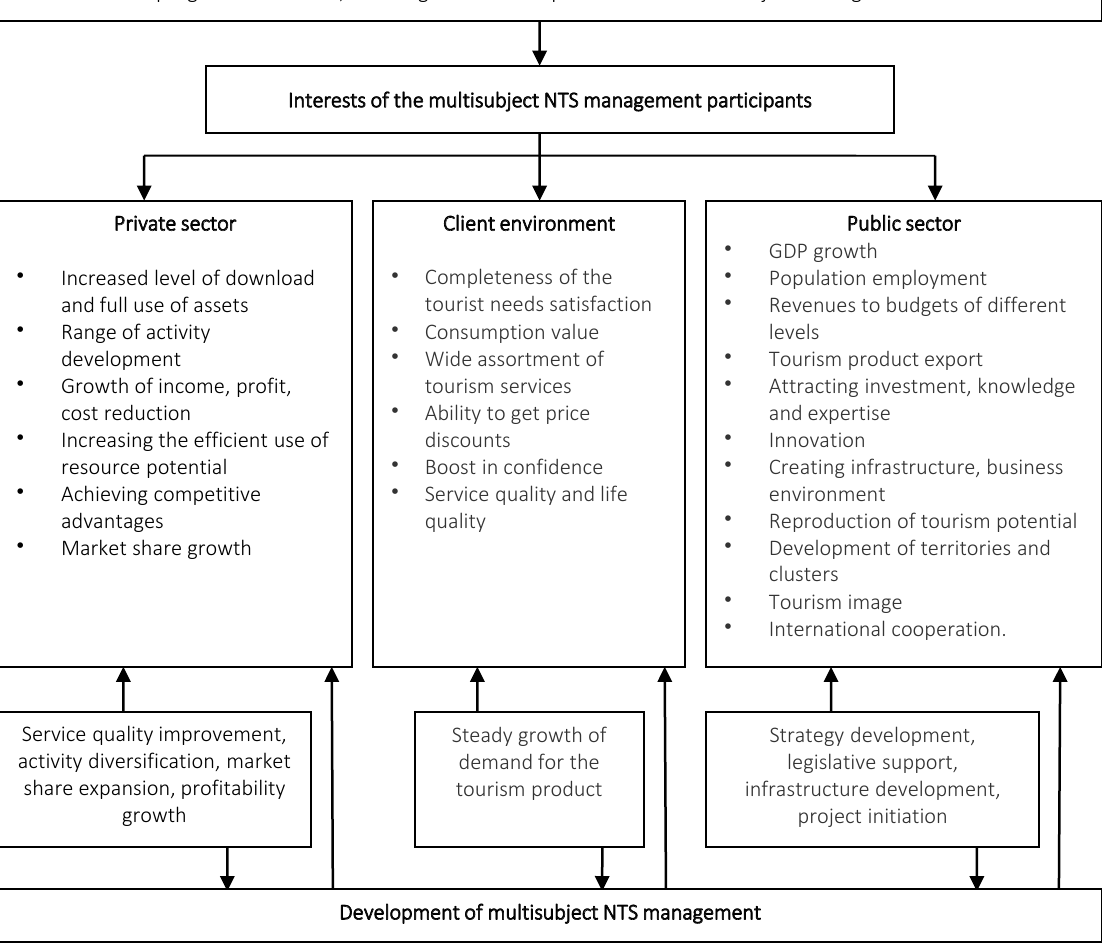
Figure 2. Communication and information field for reconciling the interests of the multisubject NTS management